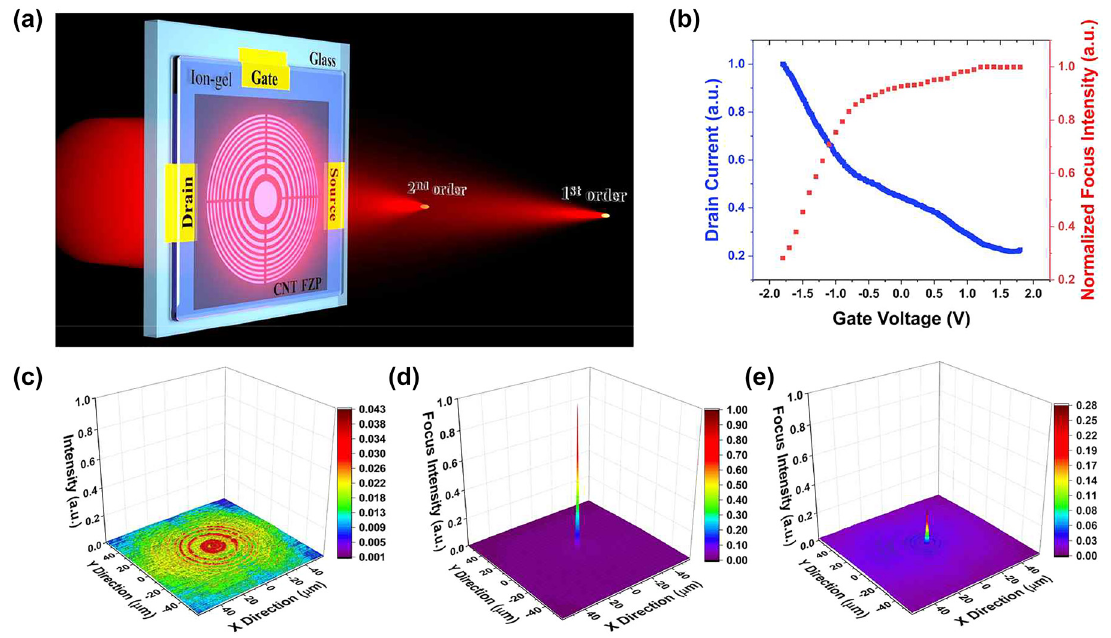
Figure 4: Gate-tunable properties of the device. (a) Schematic illustration of gate-tunable FZP fabricated on CNT network film with ion-gel coating, showing first- and second-order foci. (b) Measured drain current and the normalized intensity at focus with gate bias sweeping between + 1.8 V and − 1.8 V. (c) Measured intensity profiles of the transmitted light at the position of the FZP plane, and at the first-order focus with applied gate voltages of (d) + 1.8 V and (e) − 1.8